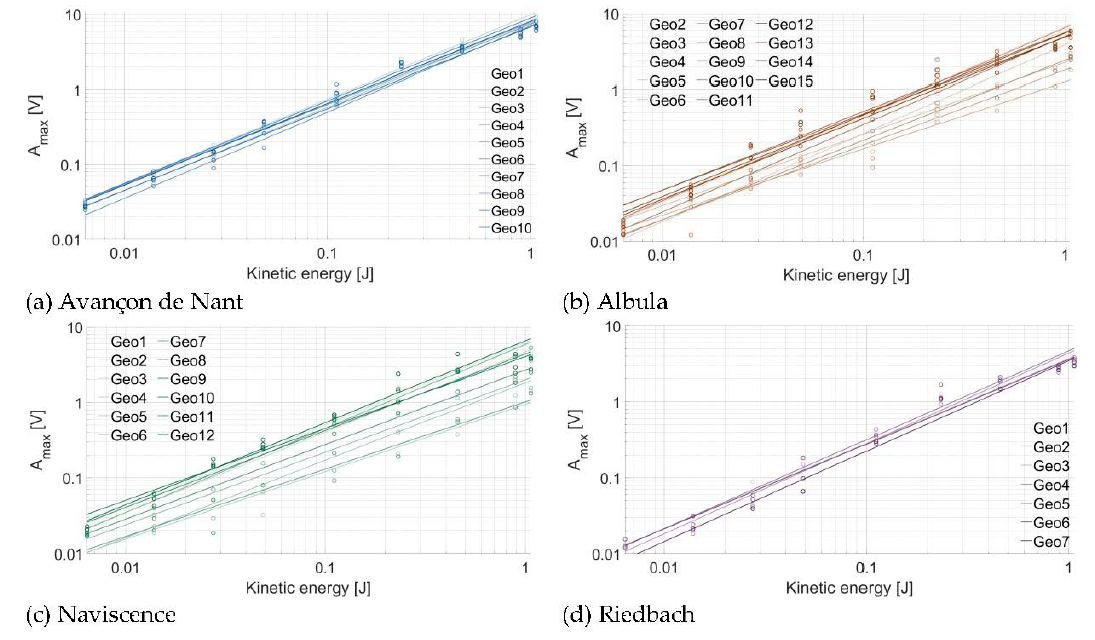
Figure 5. Relationship between the kinetic energy (J) of the impact and the associated A max at ( a ) the Avançon de Nant, ( b ) the Albula, ( c ) the Naviscence, and ( d ) the Riedbach. Each point represents the A max (V) of the given drop category repeated 10 times.